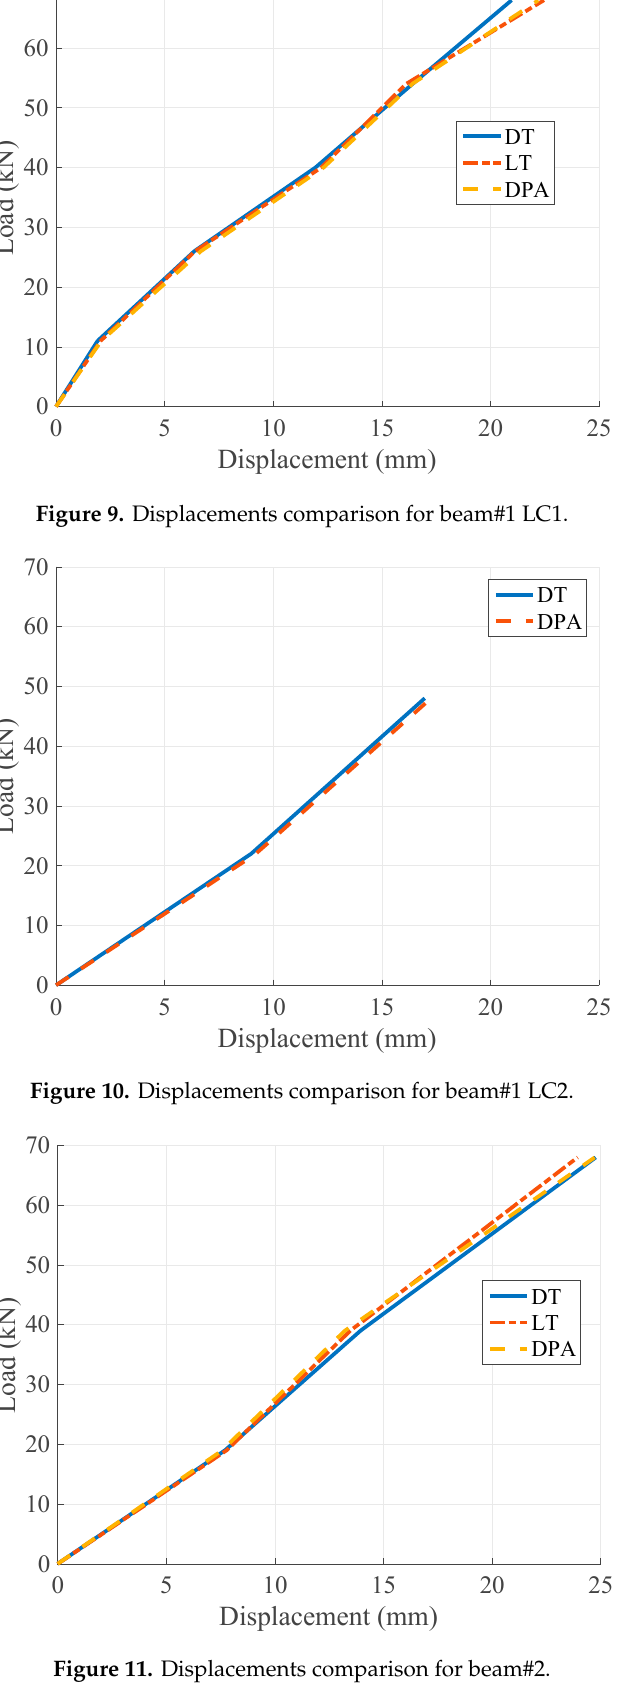
Figure 11. Displacements comparison for beam#2.